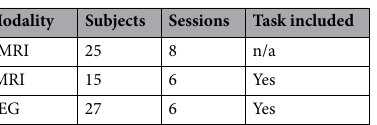
Table 2. Number of subjects and sessions for fingerprinting